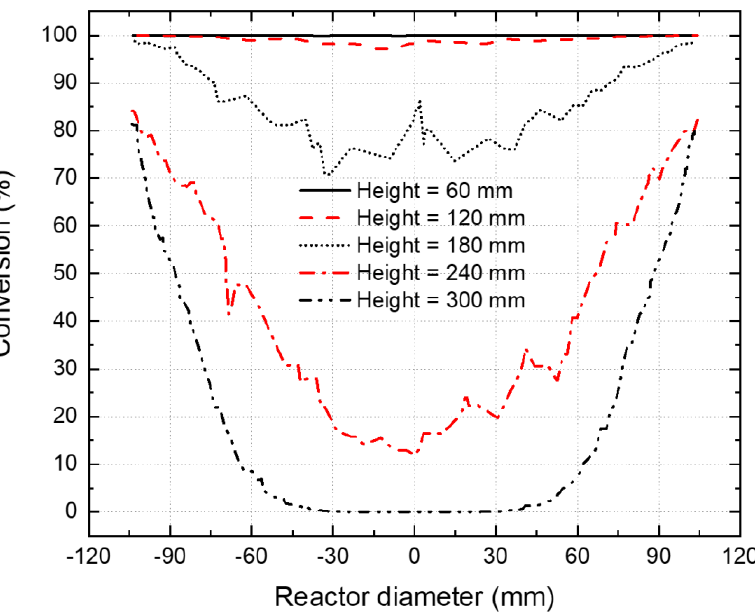
Figure 23. Methane conversion rate by height in the reactor (full cavity).